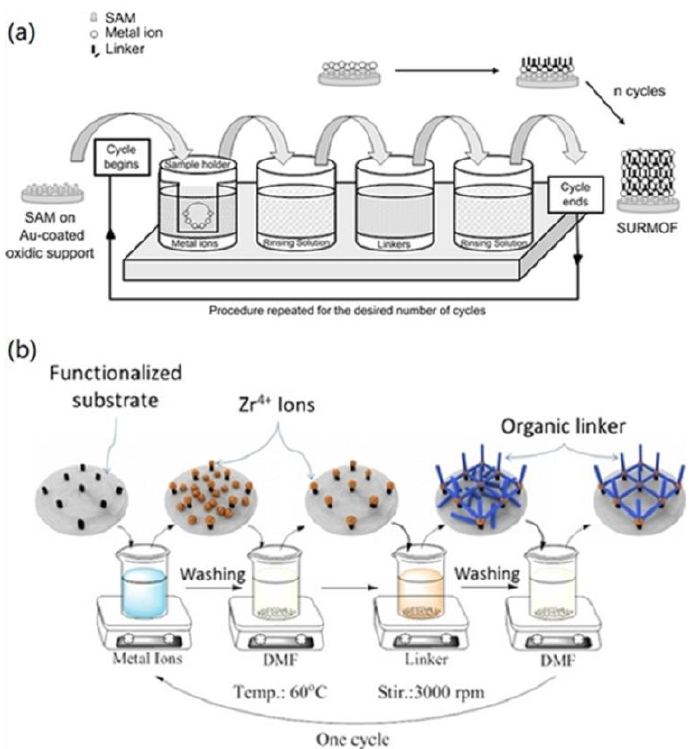
Figure 4. Schematic diagrams for the LPE growth of MOF membranes: ( a ) ZIF − 8 SURMOF membrane deposited on a Au coated alumina support and ( b ) UiO − 66 − NH 2 SURMOF membrane deposited on a flat gold − coated substrate. Reprinted with permissions from Refs. [89,90]. ln 2014, Eddaoudi and co − workers reported the assembly of ultra − thin and de- fect − free ZIF − 8 selective layers on porous aluminate supports by precisely controlling the epitaxial growth [85]. In the single − gas permeation tests of He, H 2 , CO 2 , O 2 , N 2 , CH 4 , C 2 H 4 , C 2 H 6 , C 3 H 6 , C 3 H 8 , and n − C 4 H 10 , the resultant ZIF − 8 membranes were observed to have a cut − off for the diffusion coefficient between C 2 and C 3 because of the relatively small win- dow size of ZIF − 8. Although the ZIF − 8 membranes fabricated by LPE exhibited about 100 times lower permeance but with good ideal selectivity of 5, 11, 12, and 60 for H 2 − CO 2 , H 2 − N 2 , H 2 − CH 4 , and H 2 − C 3 H 8 , respectively, at 308 K, suggesting the synthesized ZIF − 8 membranes with minimal grain boundary micro − defects. Recently, the Léon group used the LPE method and an in situ growth method to prepare an UiO − 66 − NH 2 SURMOF membrane and an UiO − 66 − NH 2 membrane, respec- tively [91]. In the equimolar case, the UiO − 66 − NH 2 SURMOF membrane exhibited a higher H 2 /N 2 separation factor of 3.02 because of the LPE method continuously generating a highly oriented MOF membrane. 2.1.5. Vapor Deposition For the MOF membranes by chemical solution deposition (CSD) typically involving reacting metal salts and organic ligands in solutions, the advantages provided are gener- ally simplicity and effectiveness, low capital cost of laboratory implementation, compati- bility with conventional wet chemical operations, and high chemical flexibility. However, the reactant transport and fluid dynamic processes of CSD are usually complex and are very difficult to control carefully, especially on an industrial scale. In contrast to CSD, vapor deposition of MOF membranes can facilitate their implementation in lab − scale re- search and industries. Usually, each vapor deposition process includes three steps: (1) evaporation, (2) the transportation of the vaporized material, (3) deposition of the film on the substrate. As of now, while there are many variations of vapor deposition, the